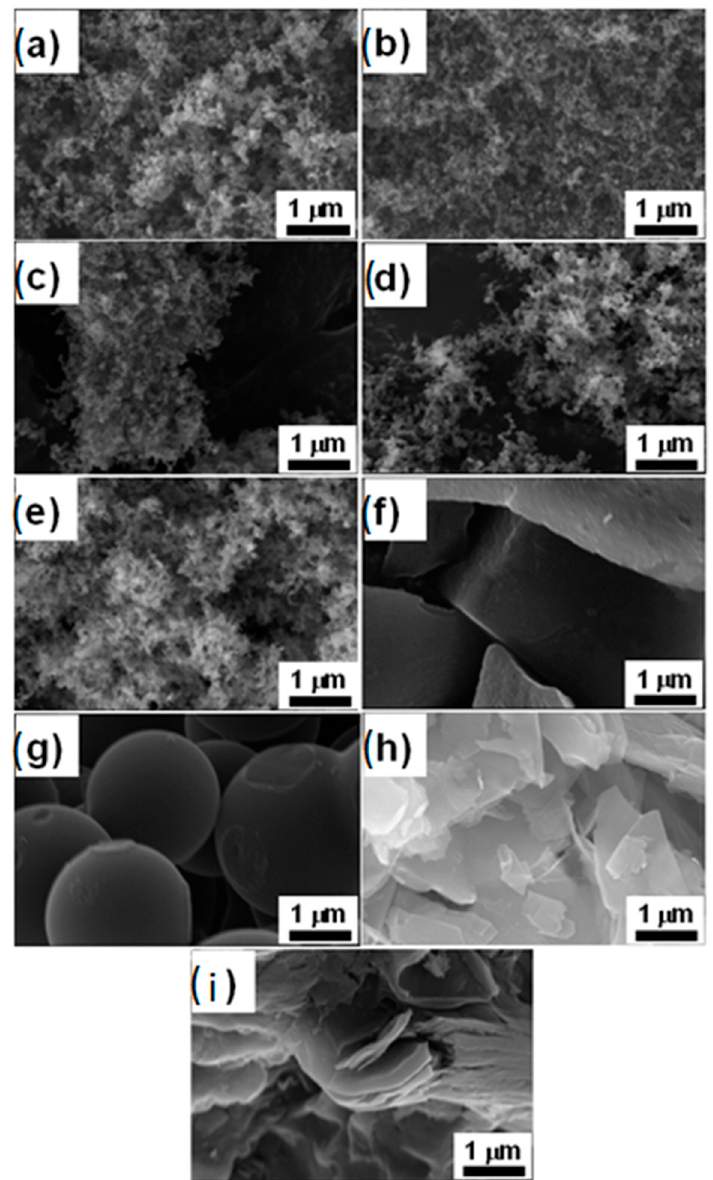
Figure 2. SEM images of ( a ) AB, ( b ) KB1, ( c ) KB2, ( d ) SuperP, ( e ) SuperP-Li, ( f ) splintered glassy carbon, ( g ) spherical glassy carbon, ( h ) KS6, and ( i ) graphite. Magnification: ×20,000.